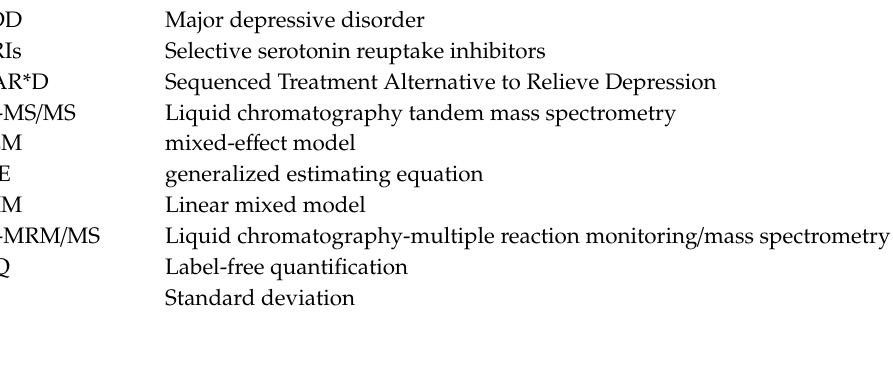
Figure S1. Box plots for protein abundances in each LC-MS / MS run. Protein abundances (a) before and (b) after endogenous protein-based normalization. (c) Two-dimensional global t-SNE map comparing the responders (blue) and non-responders (red) at each sampling time (1, 4, and 10 weeks) and 3 t-SNE parameters of perplexity. (d) Plasma protein log2 abundances (ng / mL) in the Plasma Proteome Database (bottom) and normalized protein abundance (right). Figure S2. Changes in responders over time to the amounts of 37 significant proteins belonging tosix clusters, as determinedbyresponse / timeinteraction. Clusters 1through6included 3, 5, 3, 5, 10 and11 proteins, respectively. Figure S3. Calibration curves of 15 surrogate peptides relative to nine proteins based on heavy-to-light extracted ion chromatogram ratio. Figure S4. MRM results of five proteins at T 0 vs. T 1. Boxplot of five quantified proteins paired at T 0 and T 1 in responders and non-responders. Table S1. Demographic and clinical characteristics of the ten depressed patients at each of the four hospital visits. Table S2. The 1,159 plasma proteins identified in Table S3. Log2 transformed normalized protein abundance of 316 proteins in 104 LC-MS / MS measurements. Table S4. MRM parameters optimized for 14 target peptides of nine proteins. Table S5. Spearman’s rank correlation coe ffi cients and adjusted p- values for the relationships between 316 protein abundance and six psychiatric symptom indices. Table S6. Estimation results in generalized estimation